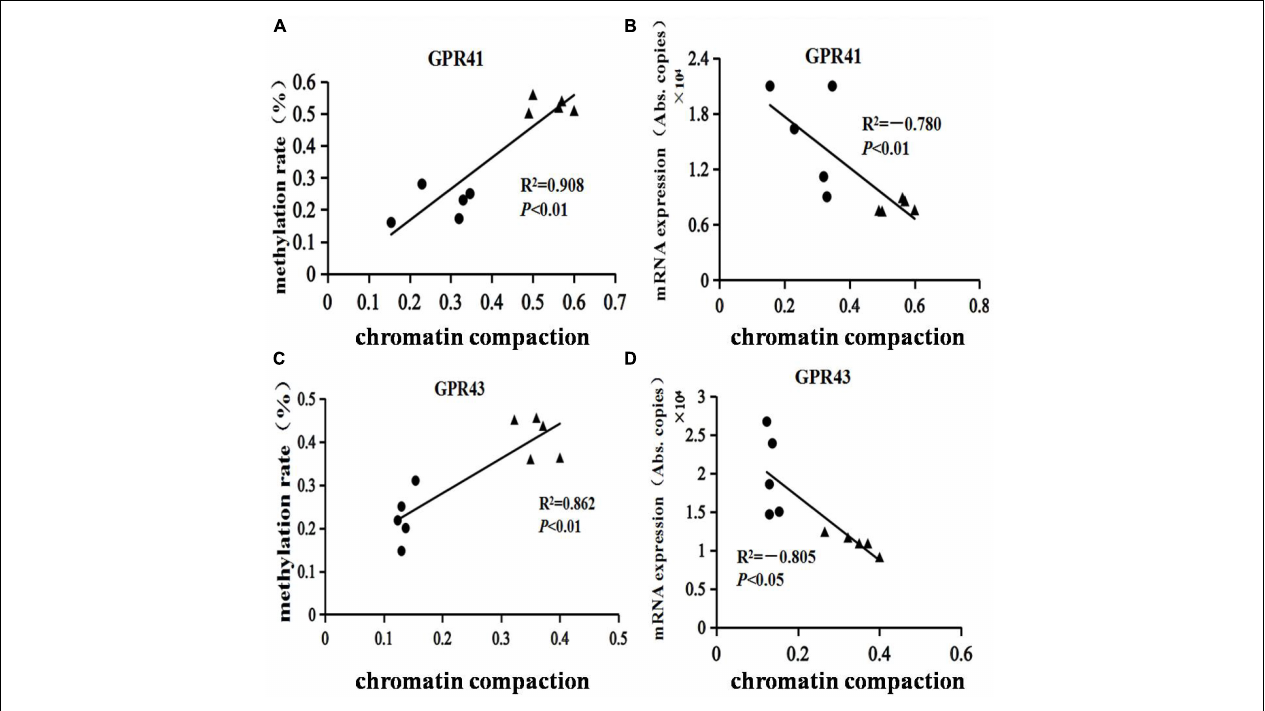
” represents the (cid:32)